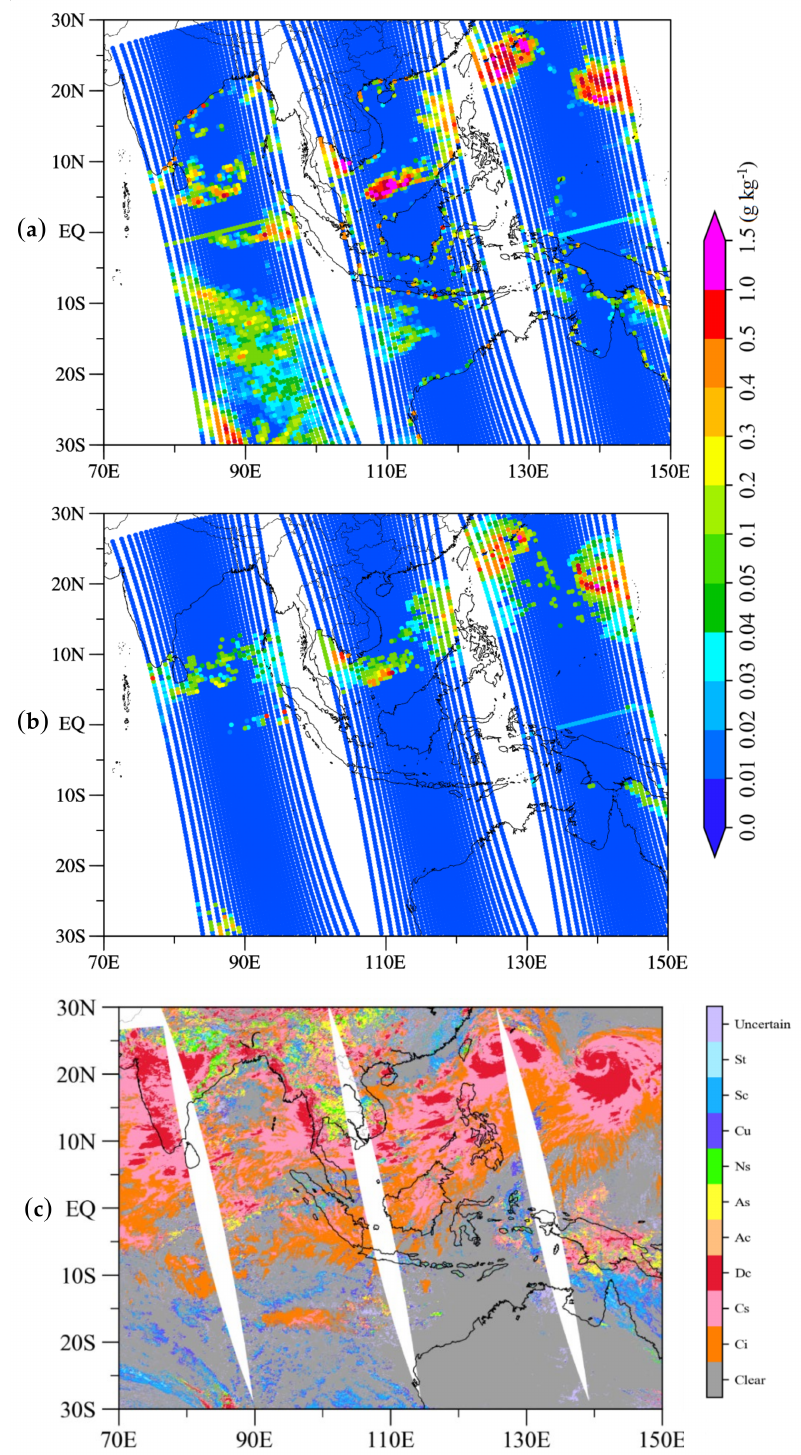
Figure 2. Spatial distribution of the integral whole-layer ( a ) LWP and ( b ) IWP from 0900 to 1500 UTC and ( c ) the MODIS cloud classification products during 0300–0900 UTC over southeast Asia on 8 August